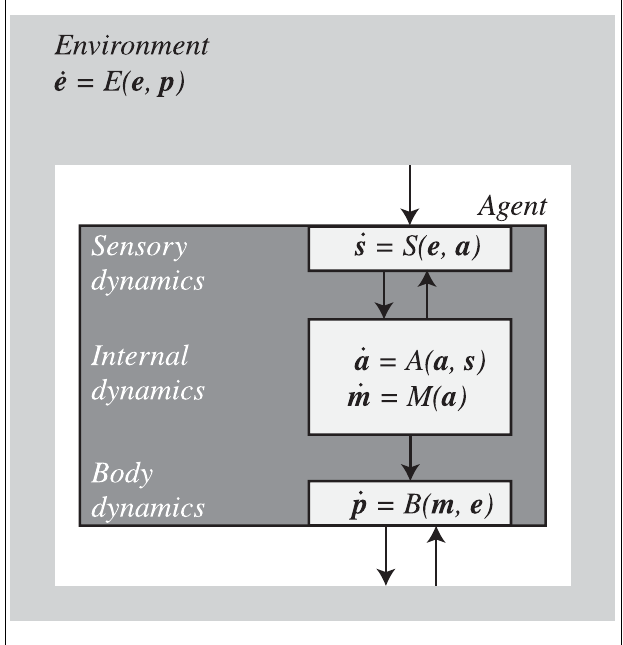
FIGURE 1 |Agent and environment as coupled dynamical systems described by differential equations .The world is partitioned into components describing the dynamics of the environment ( e ), the agent (in bodily configuration p ), and their interaction.The agent is further subdivided into sensory ( s ) and motor interfaces ( m ) as well as its internal state ( a ). For further details see